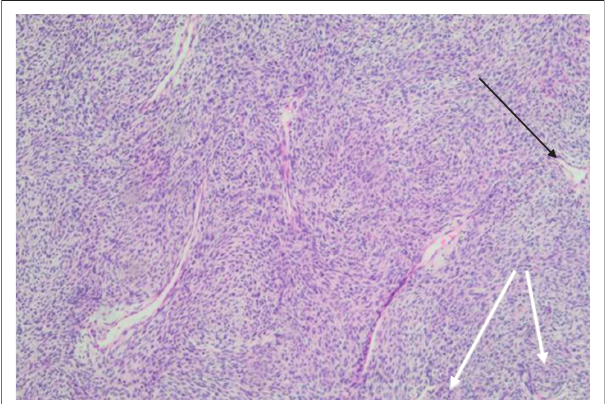
FIGURE 3: Haematoxylin and eosin staining, X 100 magnification. Overlapping spindle cells with scanty cytoplasm and hyperchromatic nuclei. Some of the cells formed small nests (white arrows) reminiscent of epithelial differentiation. Also present are stag horn blood vessels with a haemangiopericytic pattern (black